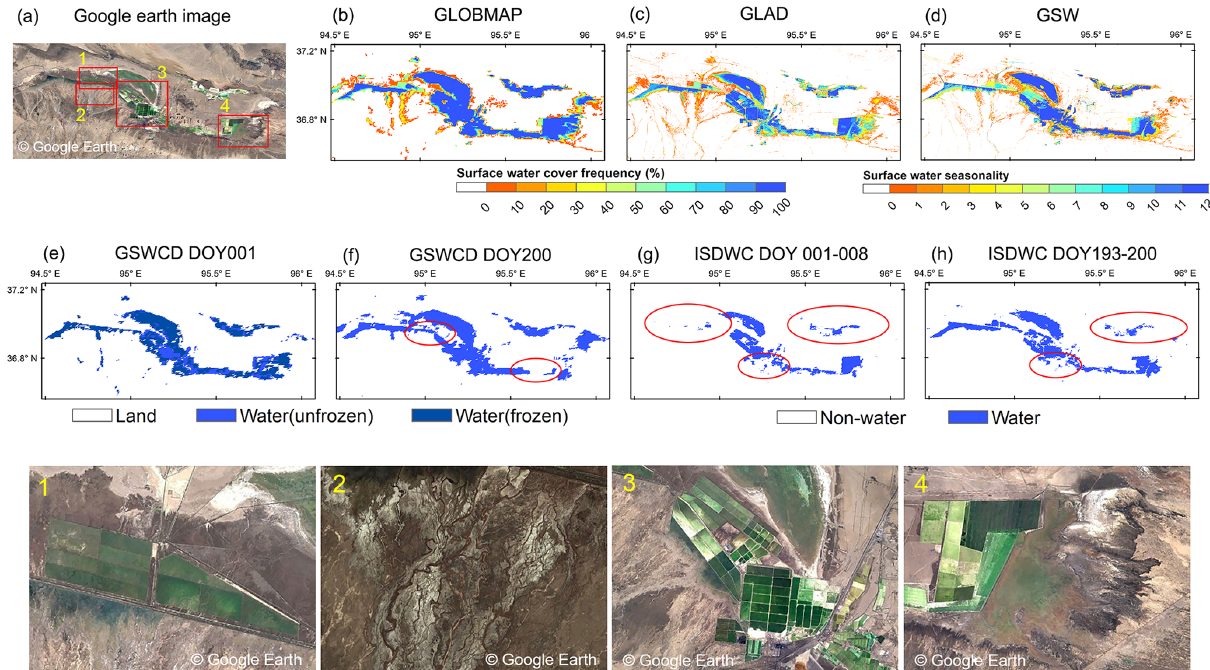
Figure 5. Comparison of surface water map of GLOBMAP SWF, GLAD, GSW, GSWCD and ISDWC for Qarhan Salt Lake in the southern Qaidam Basin in northwestern China (36.56–37.24 ◦ N, 94.48–96.08 ◦ E) in 2015. (a) Google Earth high-resolution image (from Google Earth), (b) GLOBMAP surface water cover frequency, (c) GLAD annual water percent and (d) GSW seasonality (source: EC JRC/Google). Surface water extent of GSWCD in (e) DOY001 and (f) DOY200 in 2015 and surface water extent of ISDWC in (g) DOY001–008 and (h) DOY193–200 in 2015. The last row shows the Google Earth high-resolution images for the four subregions shown with the red circles in Fig. 6a (from Google